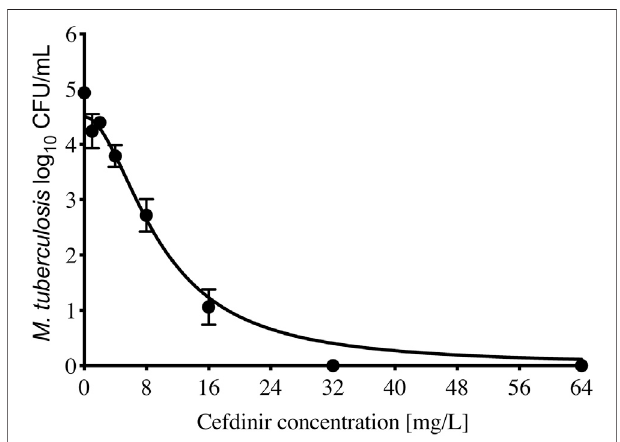
FIGURE 2 | Cefdinir ef fi cacy against M. tuberculosis . Compare to the non-treatedcontrols,cefdiniraloneataconcentrationof32 mg/Lkilled4.93+ 0.07 log 10 CFU/ml log-phase growth Mtb in 7 days static concentration